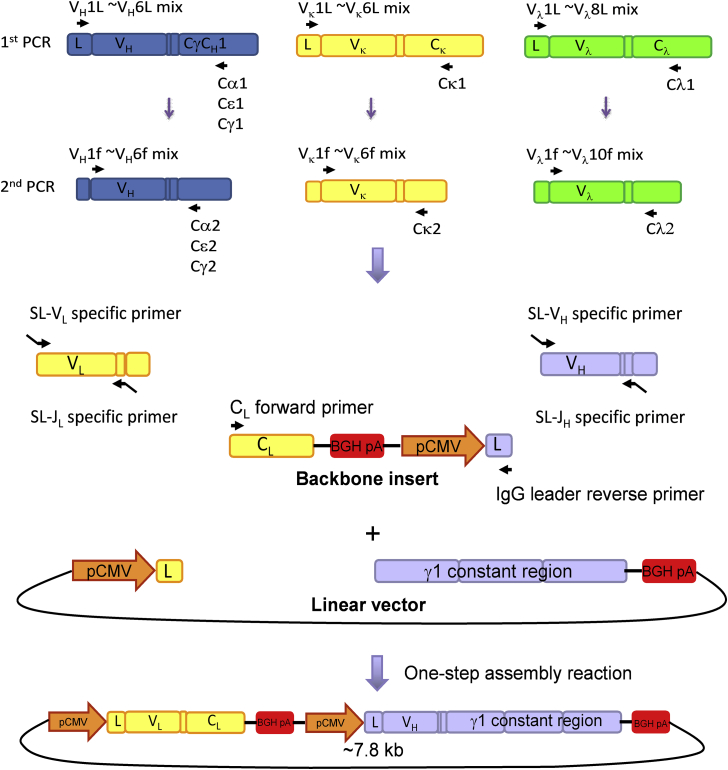
Cloning strategy for constructing recombinant IgG1 expression vector. Paired VH and VL regions from sorted single SAE-specific B cells were amplified by means of RT-PCR and sequenced as described in the Methods section in this article's Online Repository. The 15-bp homologous arm was introduced by means of PCR to permit cloning into pIgG1(κ) or pIgG1(λ) vectors by means of homologous recombination with the Seamless method, as described in the Methods section in this article's Online Repository. CL, Constant region of the light chain; JH, J region of the heavy chain; JL, J region of the light chain; L, leader; SL, seamless.